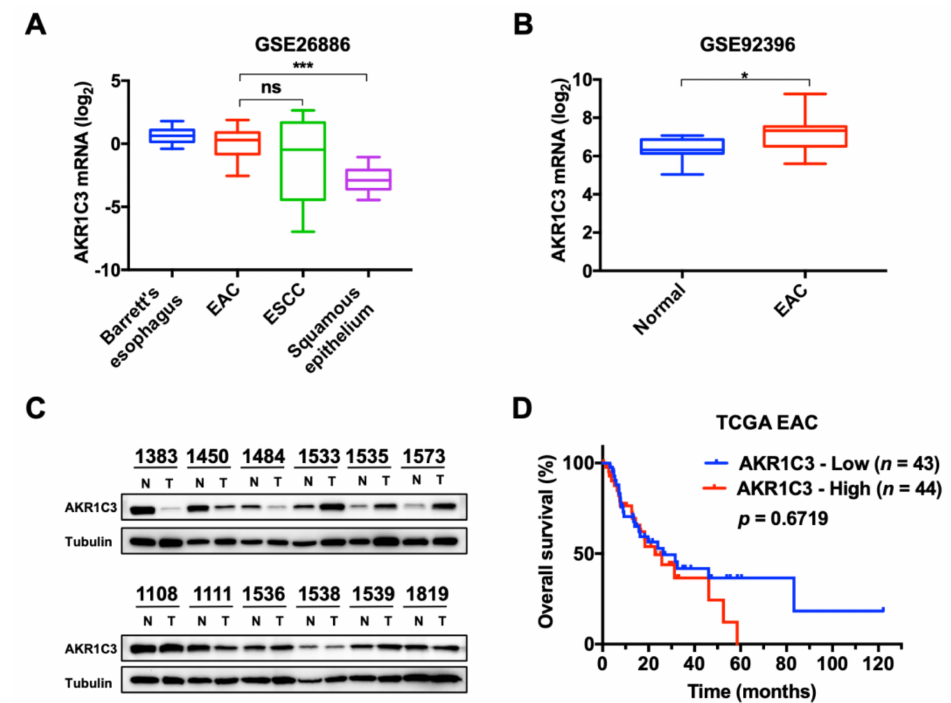
Figure 1. AKR1C3 expression was upregulated in esophageal adenocarcinoma cancer and indicated poor prognosis from public databases. ( A ) Date of GSE26886 showed that AKR1C3 expression level was significantly higher in Barrett’s esophagus, EAC and ESCC than in the corresponding squamous epithelium (BE, n = 20; EAC, n = 21; ESCC, n = 9; Squamous epithelia, n = 19). ( B ) Date of GSE92396 also showed that AKR1C3 expression level was significantly higher in EAC than in the corresponding normal esophageal tissue (Normal, n = 10; EAC, n = 12). ( C ) Western blot results showed the expression of AKR1C3 in 12 pairs of EAC tissues (T) and matched adjacent normal tissues (N). ( D ) Data from TCGA-ESCA was applied for survival analysis and the EAC subgroup was extracted. Kaplan–Meier survival analysis shows that higher AKR1C3 mRNA expression is associated with a trend of poor survival. * p < 0.05, *** p <